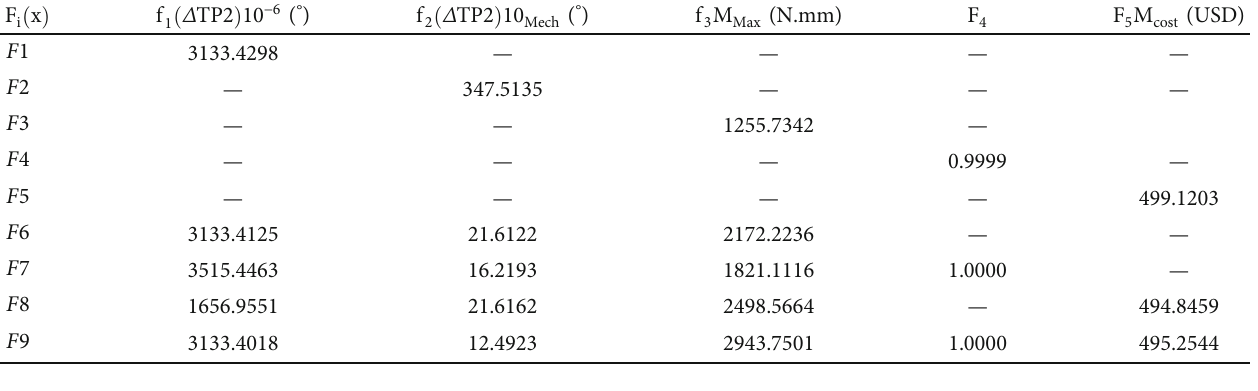
Table 5: Thumb optimization problem versus optimum objective function values.